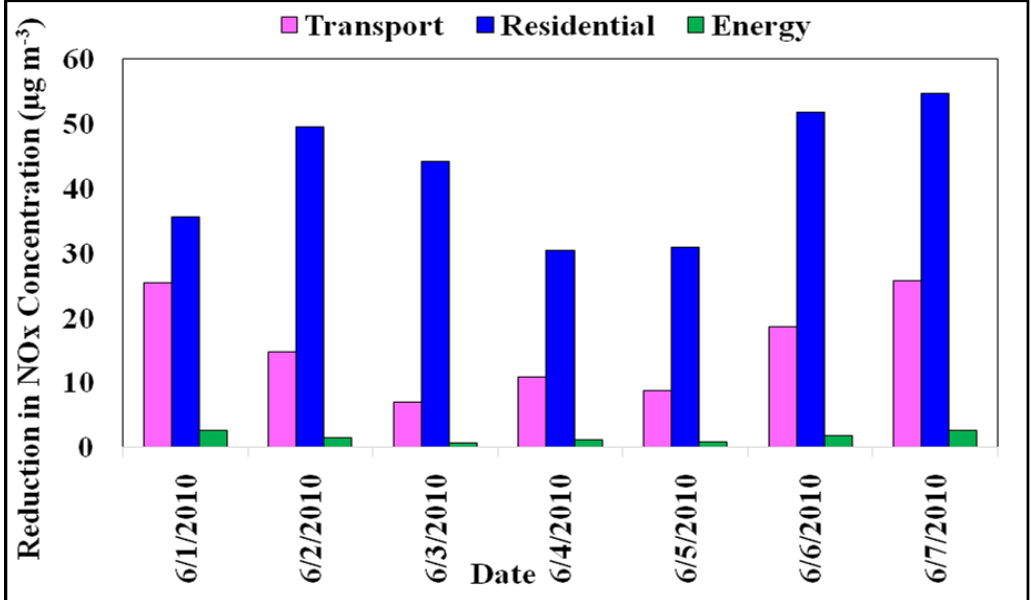
Figure 4. Reduction plots of simulated NOx concentrations (µg m −3 ) representing the difference between original and proposed emission scenarios for transport (pink), residential (blue), and energy (green) sectors, averaged for the entire simulation period over the Delhi domain.